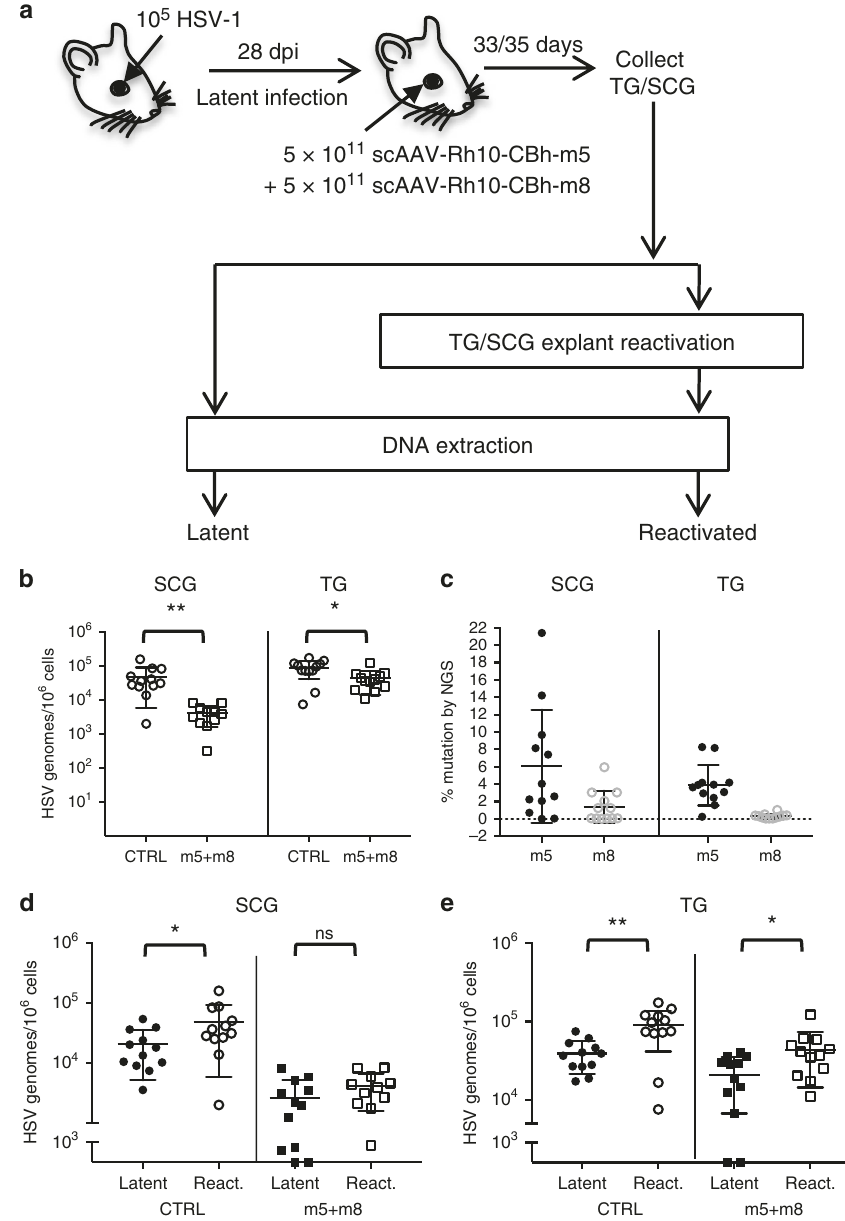
Fig. 4 Reactivation after dual-meganuclease therapy. a Ganglia from a second set of mice latently infected and treated with dual-meganuclease therapy at the same time as those described in Fig. 2d – f, were subjected to ganglia (SCG/TG) explant reactivation (see “ Methods ” ) prior to DNA extraction. b ddPCR quanti fi cation of HSV genomes in reactivated SCG and TG from latently infected untreated control mice (CTRL, open circles, n = 12) or dual- meganuclease-treated mice (open squares, n = 12). p = 0.002 and p = 0.01 for SCG and TG, respectively. c NGS analysis in reactivated SCG and TG from dual-meganuclease-treated mice to detect HSV gene editing at either the m5 (m5, closed circles) or m8 (m8, open circles) target sites. d , e Comparison of HSV loads in SCG and TG from latently infected (closed circles) and reactivated (open circles) control mice (CTRL), p = 0.02 for SCG, and from latently infected (closed squares) or reactivated (open squares) dual-meganuclease-treated mice (m5 + m8), p = 0.0012 and p = 0.012 for d SCG and e TG, respectively. * p < 0.05; ** p < 0.01; ns: not signi fi cantly different. All data are presented as mean values ± SD. Statistical analysis was conducted using unpaired multiple t -tests without correction for multiple comparison ( c ) and one-tail, unpaired t -test ( d , e ). Source data are provided as a Source data fi